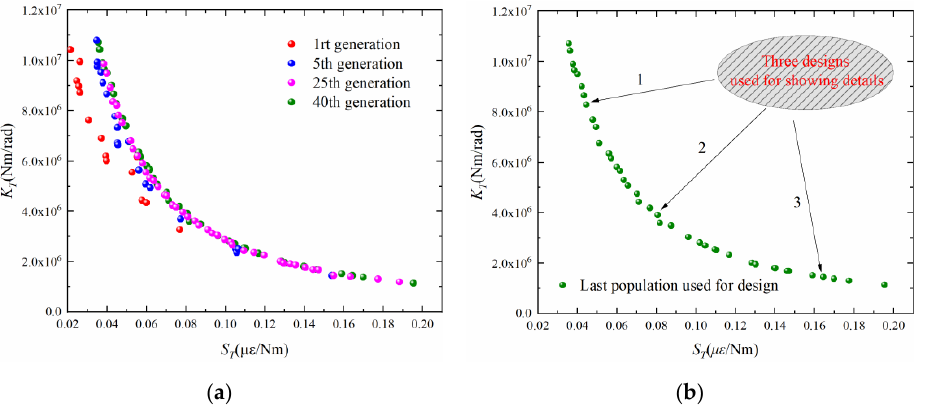
Figure 8. Population evolution process and the last population: ( a ) population evolution process; ( b ) the last population.